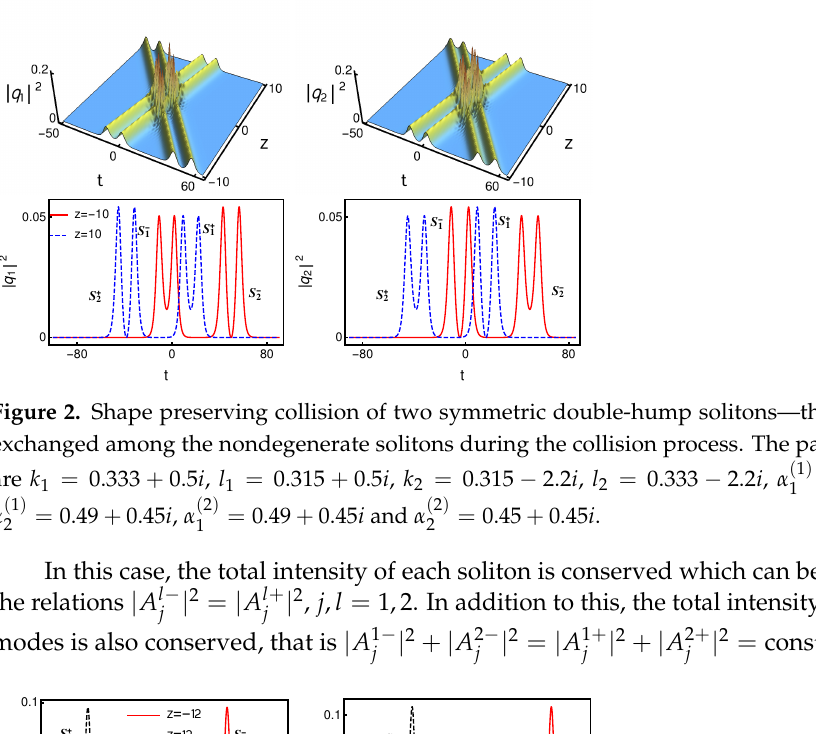
( 1 ) = 0.45 + 0.45 i , 1